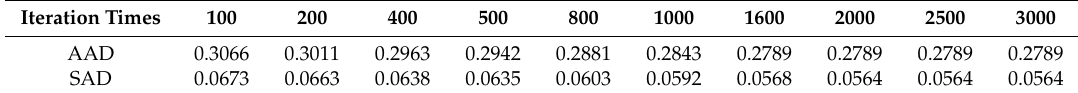
Table 2. AAD and SAD accuracy versus iteration times.